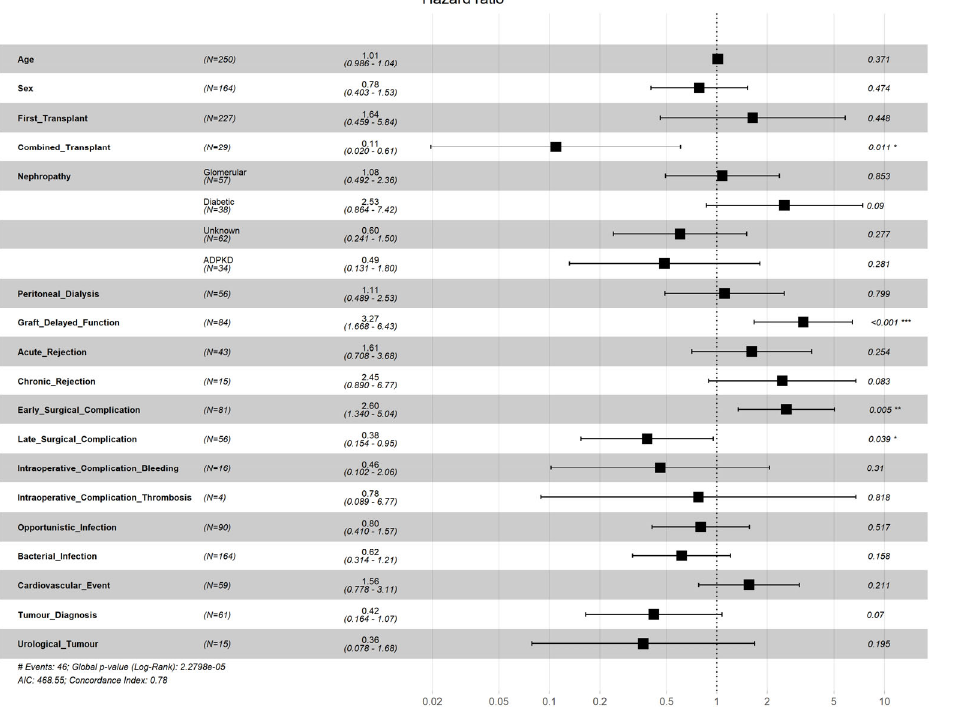
Figure 7. Results of the Cox proportional hazards model for graft survival, including the clinical selection of the studied variables. * p ‐ value < 0.05, ** p ‐ value < 0.01, *** p ‐ value < 0.001.